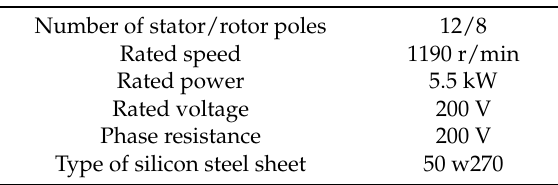
Table 1. Specification of SRM.